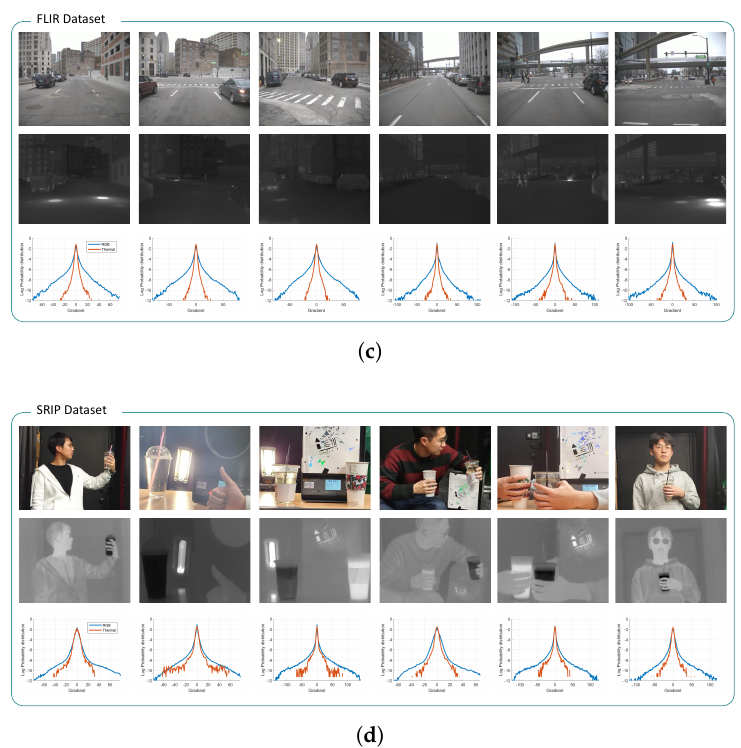
Figure 4. Visual comparison between visible-band images and infrared images for several datasets. Additionally, they are compared through their gradient distributions in the log scale. In the distribu- tions, the blue and red lines represent the RGB images and thermal images, respectively. ( a ) Trimodal dataset [27]; ( b ) CATS dataset [28]; ( c ) FLIR dataset [29]; ( d ) SRIP dataset